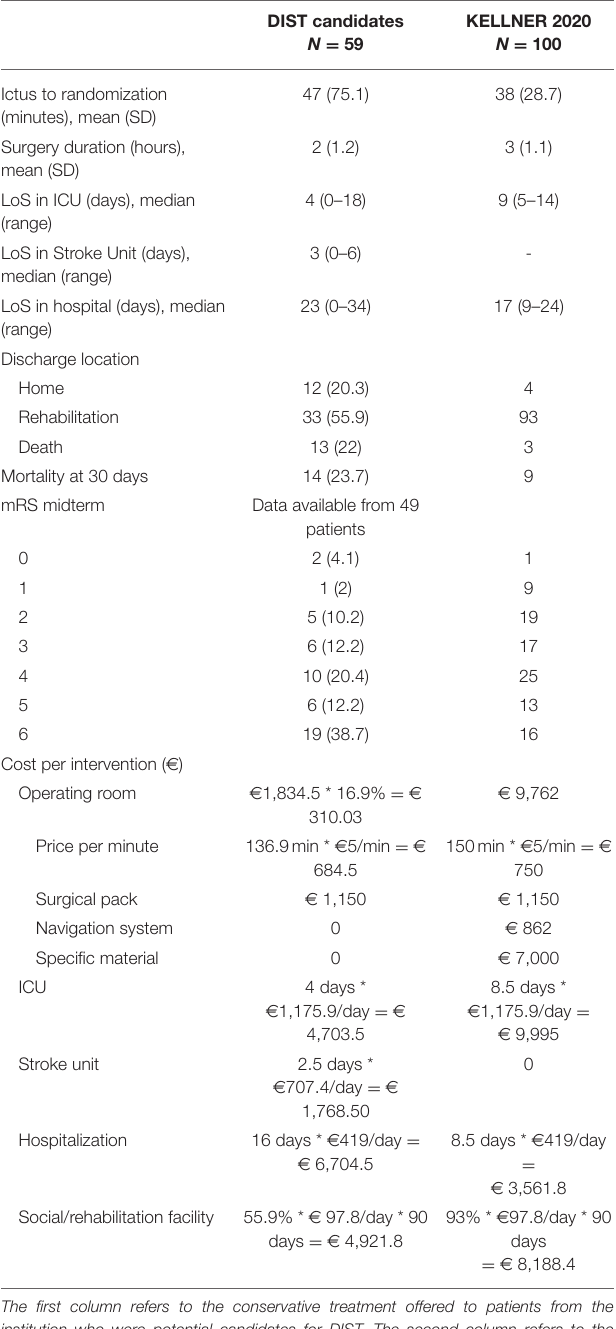
TABLE 5 | Comparison of hospital resources needed for the two treatment alternatives, plus estimation of total